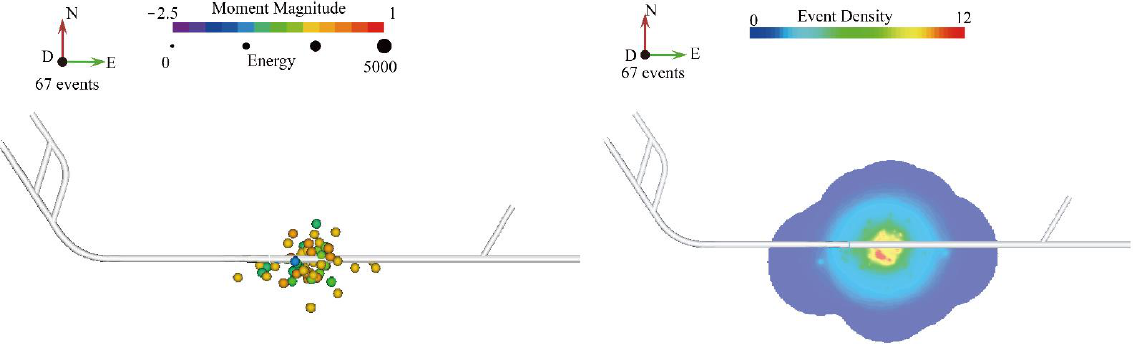
Figure 15. Distribution of the moment magnitude and density of MS events controlled by excavation unloading intensity.